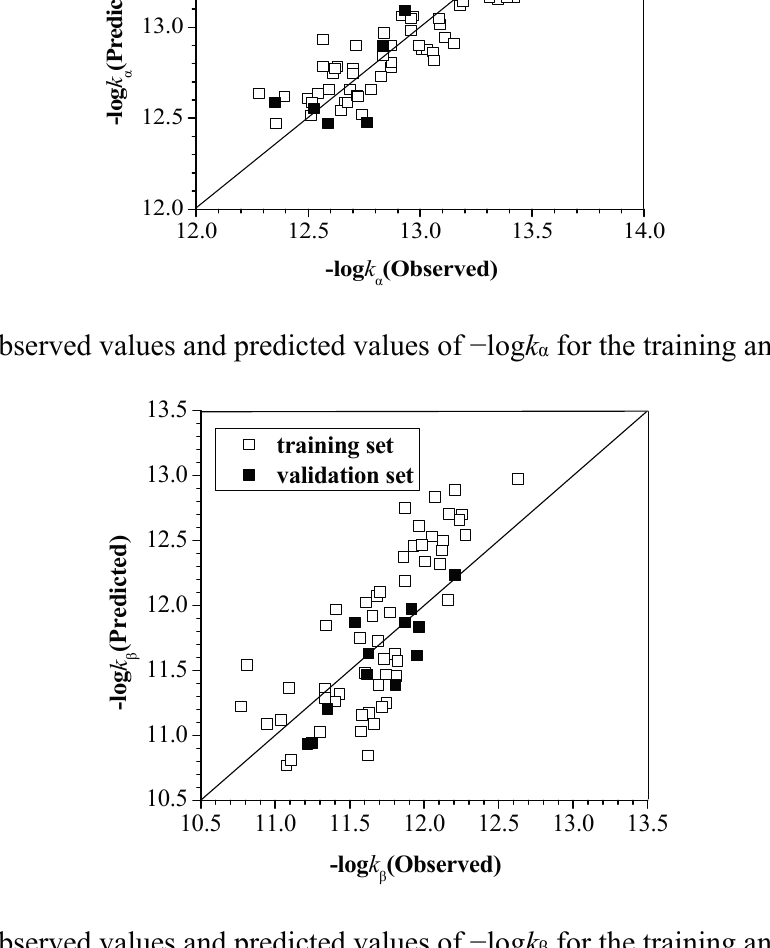
Figure 3. The observed values and predicted values of − log k β for the training and validation set.